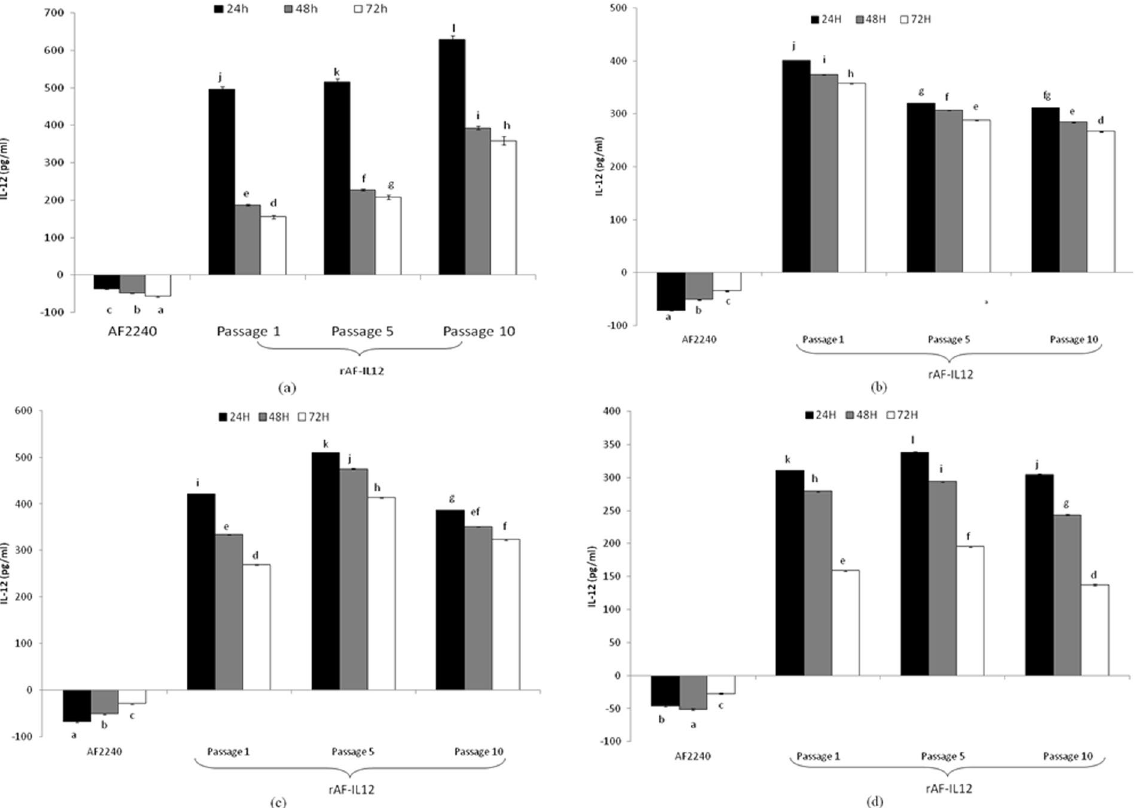
Figure 2. The expression of human IL-12 in multiple cell lines infected with NDV AF2240 and rAF-IL12 (Passages 1, 5 & 10) determined by ELISA assay at 24, 48 and 72 h. ( a ) DF-1 cells treated with NDV AF2240 and rAF-IL12 (Passages 1, 5 & 10), ( b ) MCF-7 cells treated with NDV AF2240 and rAF-IL12 (Passages 1, 5 & 10), ( c ) MDA-MB231 cells treated with NDV AF2240 and rAF-IL12 (Passages 1, 5 & 10), ( d ) MCF10A cells treated with NDV AF2240 and rAF-IL12 (Passages 1, 5 & 10). The values are expressed as the mean values ± standard deviation of triplicate experiments. The mean values as indicated using different superscript letters were significantly different at p < 0.05 when compared between parental AF2240- and rAF-IL12 (Passages 1, 5 & 10)-treated